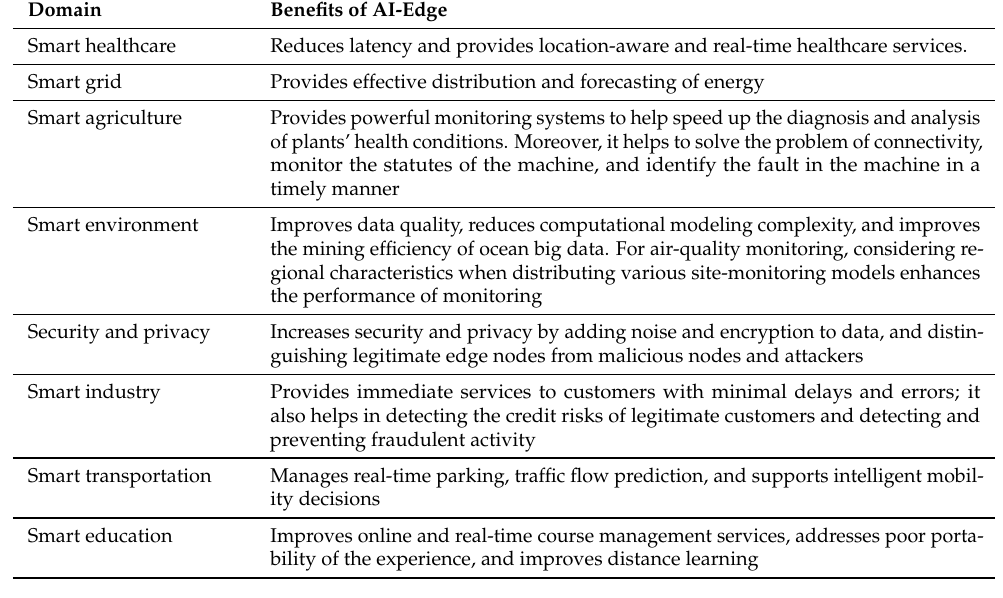
Table 11. The benefits of the integration of AI and edge in the eight reviewed domains.